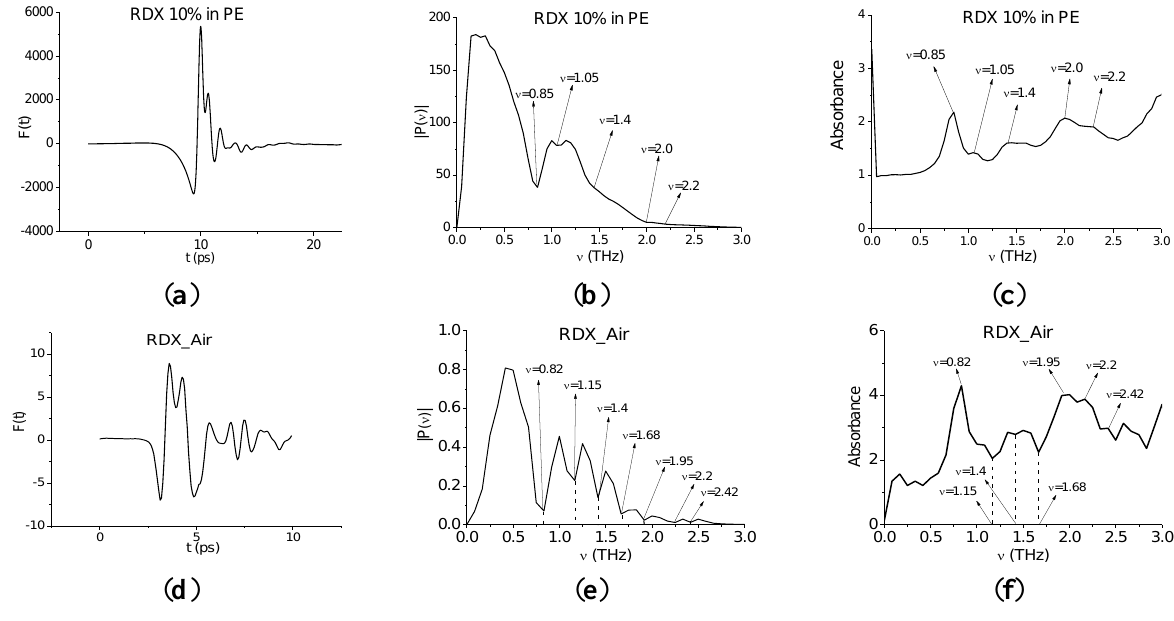
Figure 4. Transmitted THz signals RDX10 ( a ); RDX_Air ( d ); their Fourier spectra ( b , e ) and absorbance ( c , f